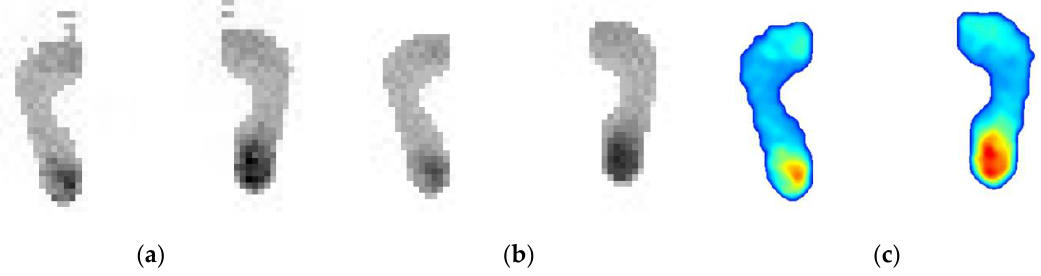
Figure 12. The results of automatic processing based on the proposed method for the flat feet. ( a ) is the original plantar pressure image of the flat feet, ( b ) is result after using the proposed method and ( c ) is the interpolation color image of ( b ).